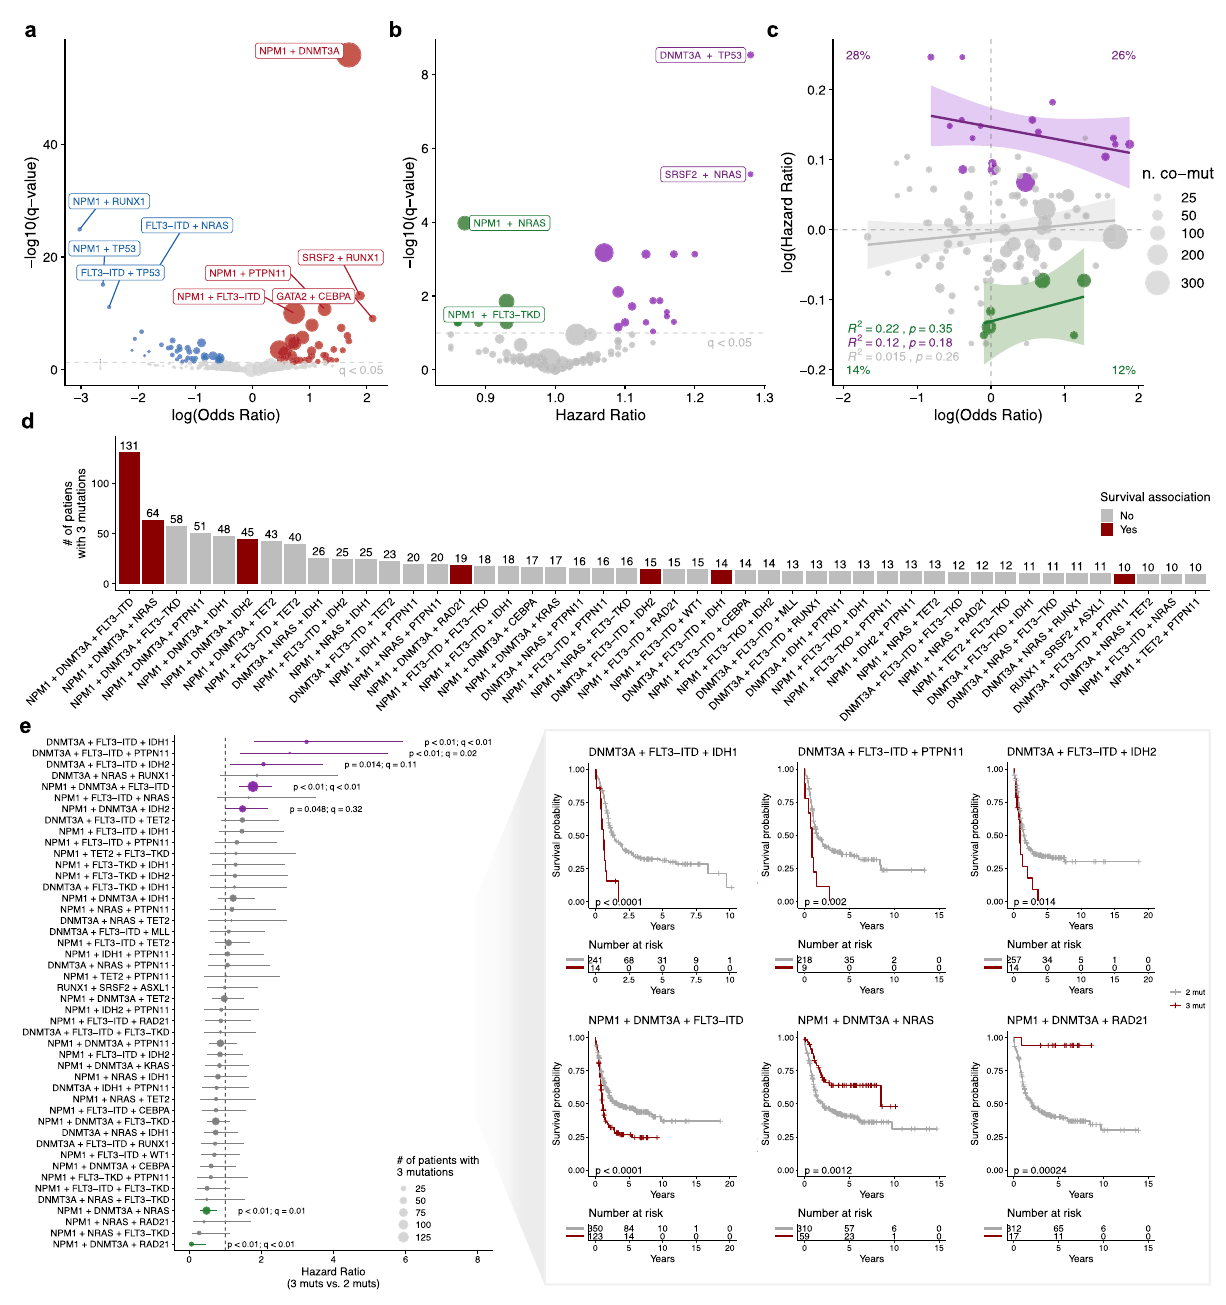
mutations in DNMT3A, NPM1 , and FLT3-ITD ( q < 0.01; HR = 1.77; 95% CI: 1.37 – 2.29), in addition to improved outcomes in patients with mutations in DNMT3A , NPM1 , and NRAS our analysis revealed unreported survival correlations for four genotypes: DNMT3A : FLT3-ITD : IDH1 ( q < 0.01; HR = 3.26; 95%